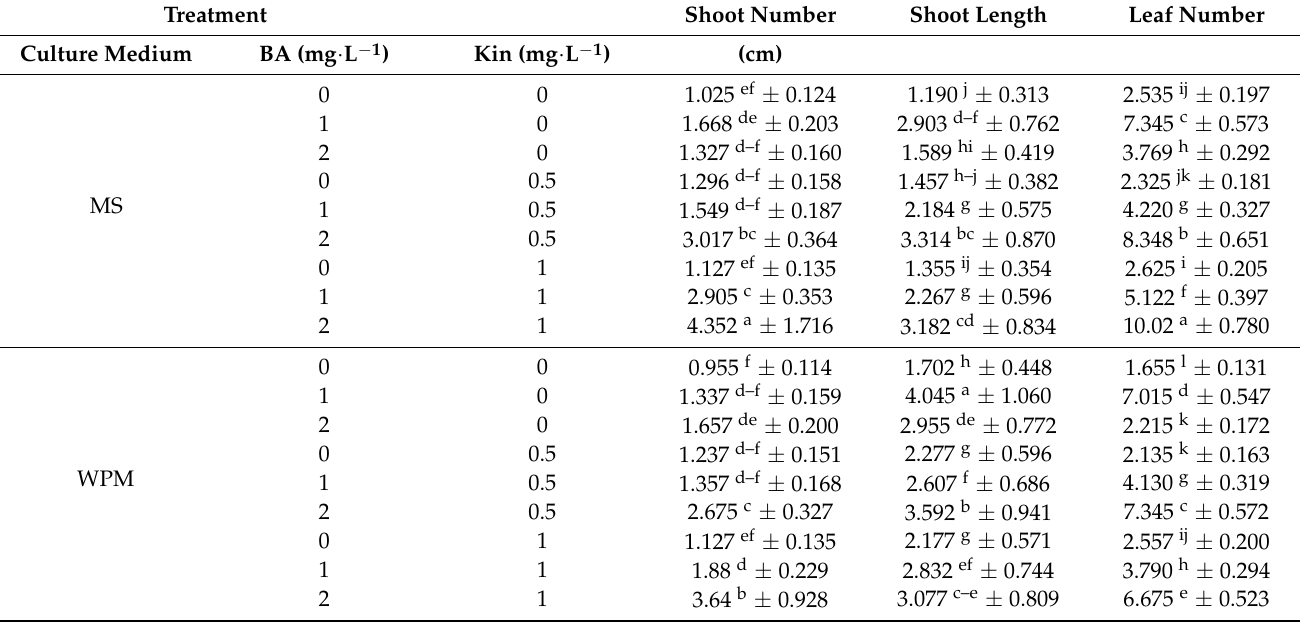
Table 1. Effect of different concentrations of BA and Kin, and culture medium type on shoot